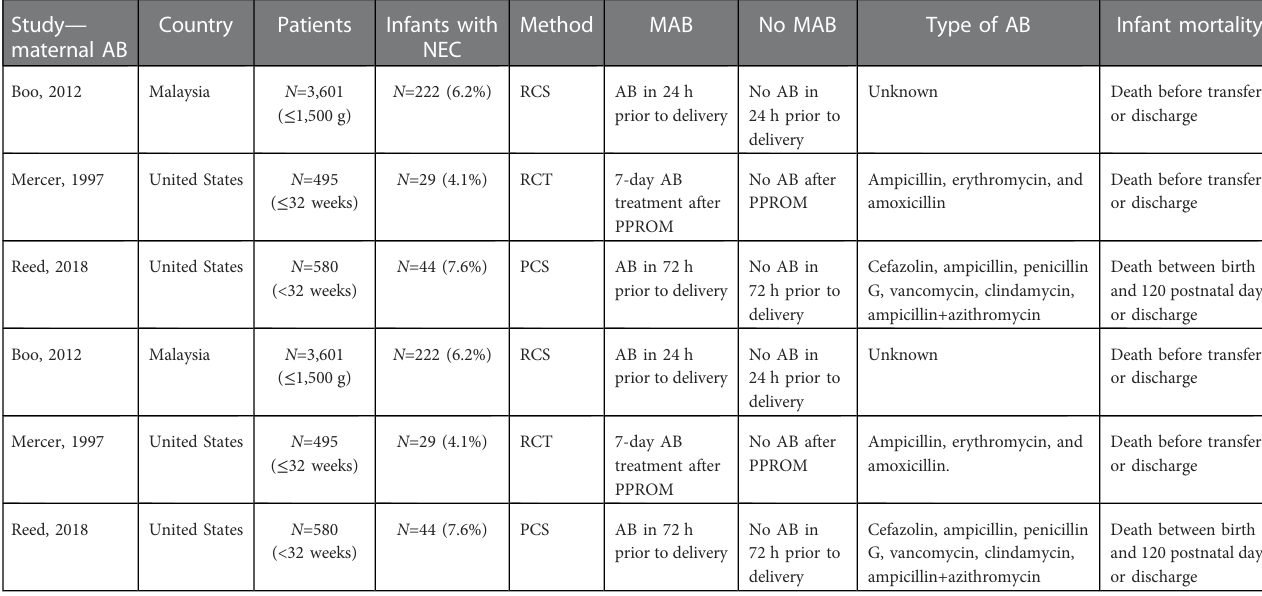
MAB, maternal antibiotics; AB, antibiotics; NEC, necrotizing enterocolitis; RCS, retrospective cohort study; PCS, prospective cohort study; RCT, randomized controlled trial; PPROM, preterm premature rupture of membranes.